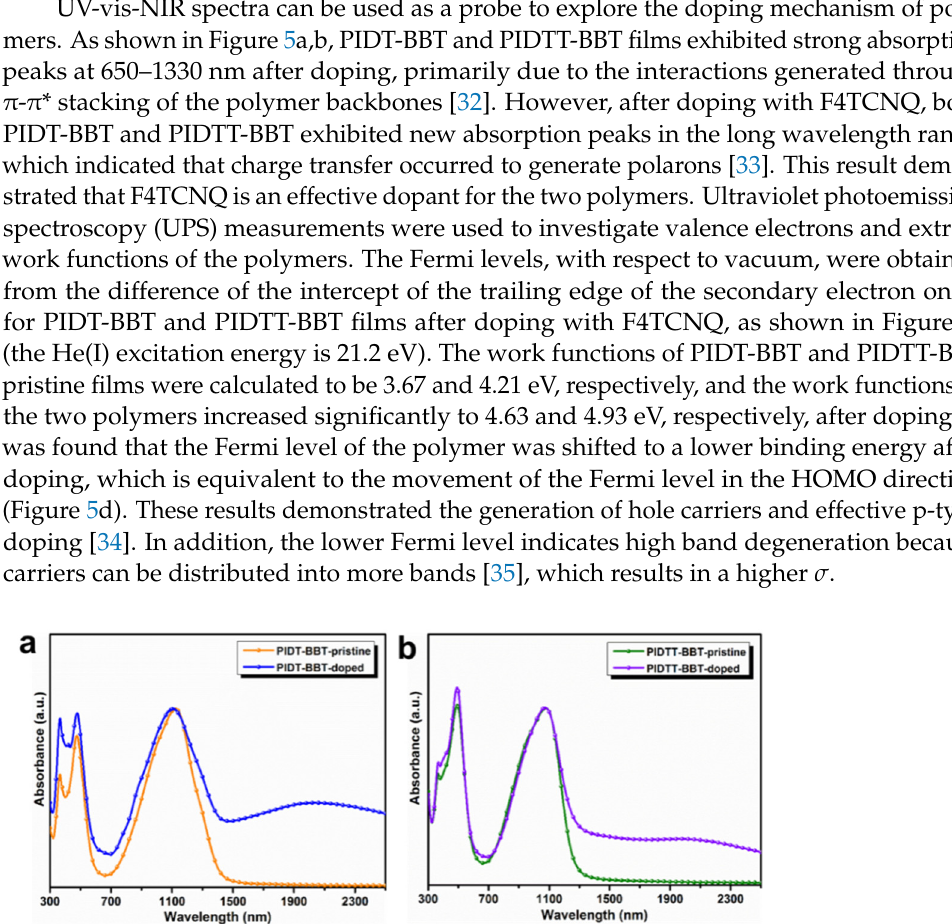
Figure 4. GI-XRD curves of pristine and doped ( a ) PIDT-BBT and ( b ) PIDTT-BBT films; XPS spectra of pristine and doped ( c ) PIDT-BBT and ( d ) PIDT-BBT films.